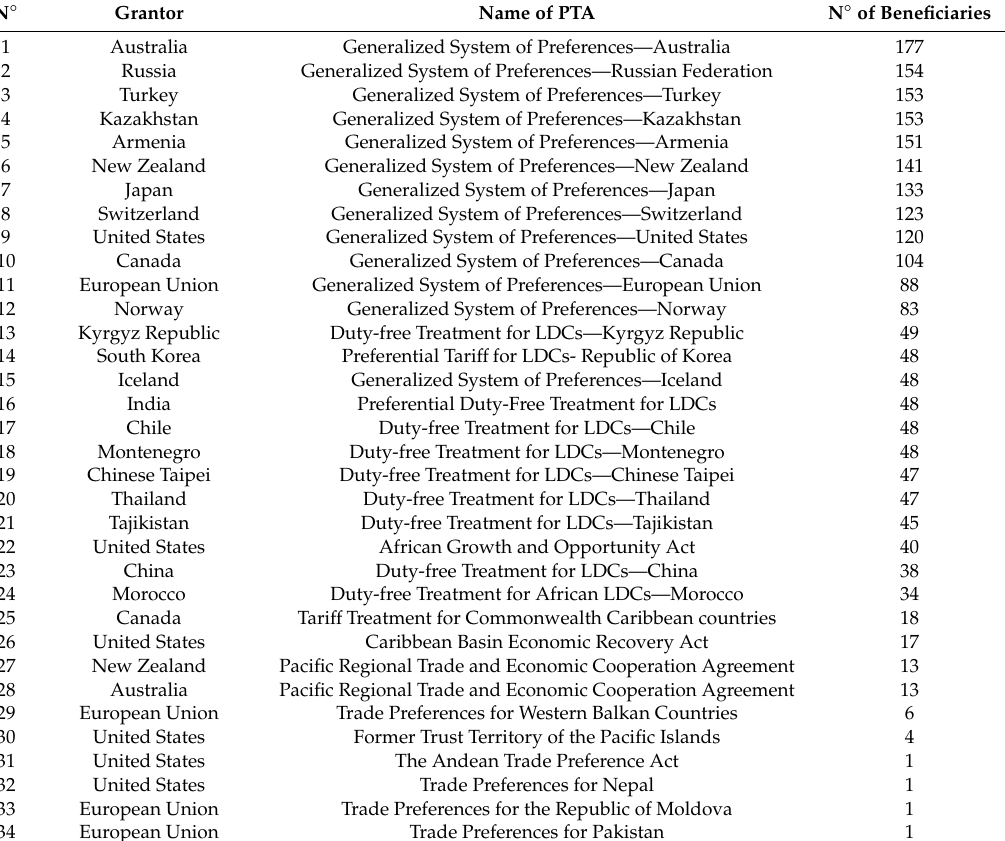
Table 3. List of PTAs by the number of beneficiary